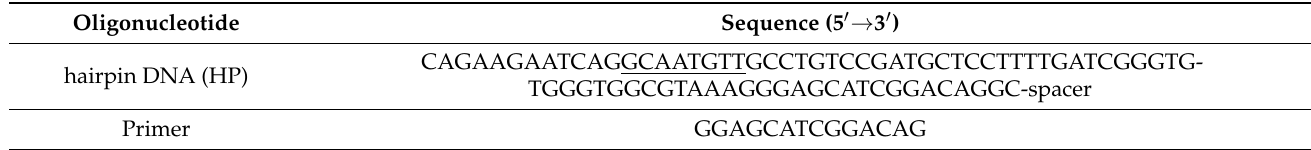
Table 1. The nucleic acid sequences used in this study. Oligonucleotide Sequence (5 (cid:48) → 3 (cid:48) ) CAGAAGAATCAGGCAATGTTGCCTGTCCGATGCTCCTTTTGATCGGGTG- hairpin DNA (HP) TGGGTGGCGTAAAGGGAGCATCGGACAGGC-spacer Primer